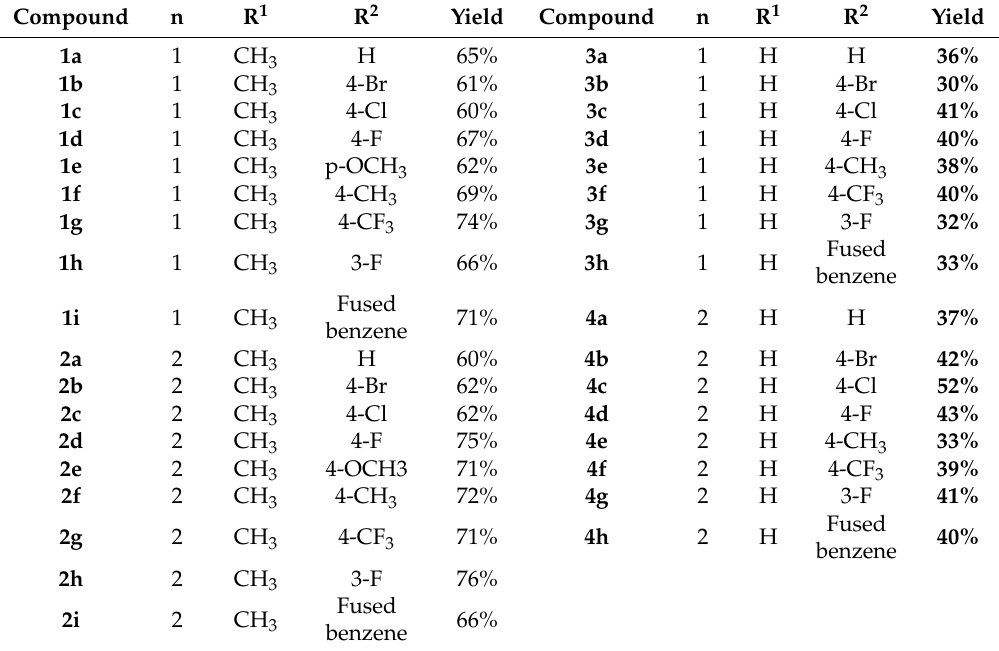
Table 1. Structures and yields of the final target compounds.